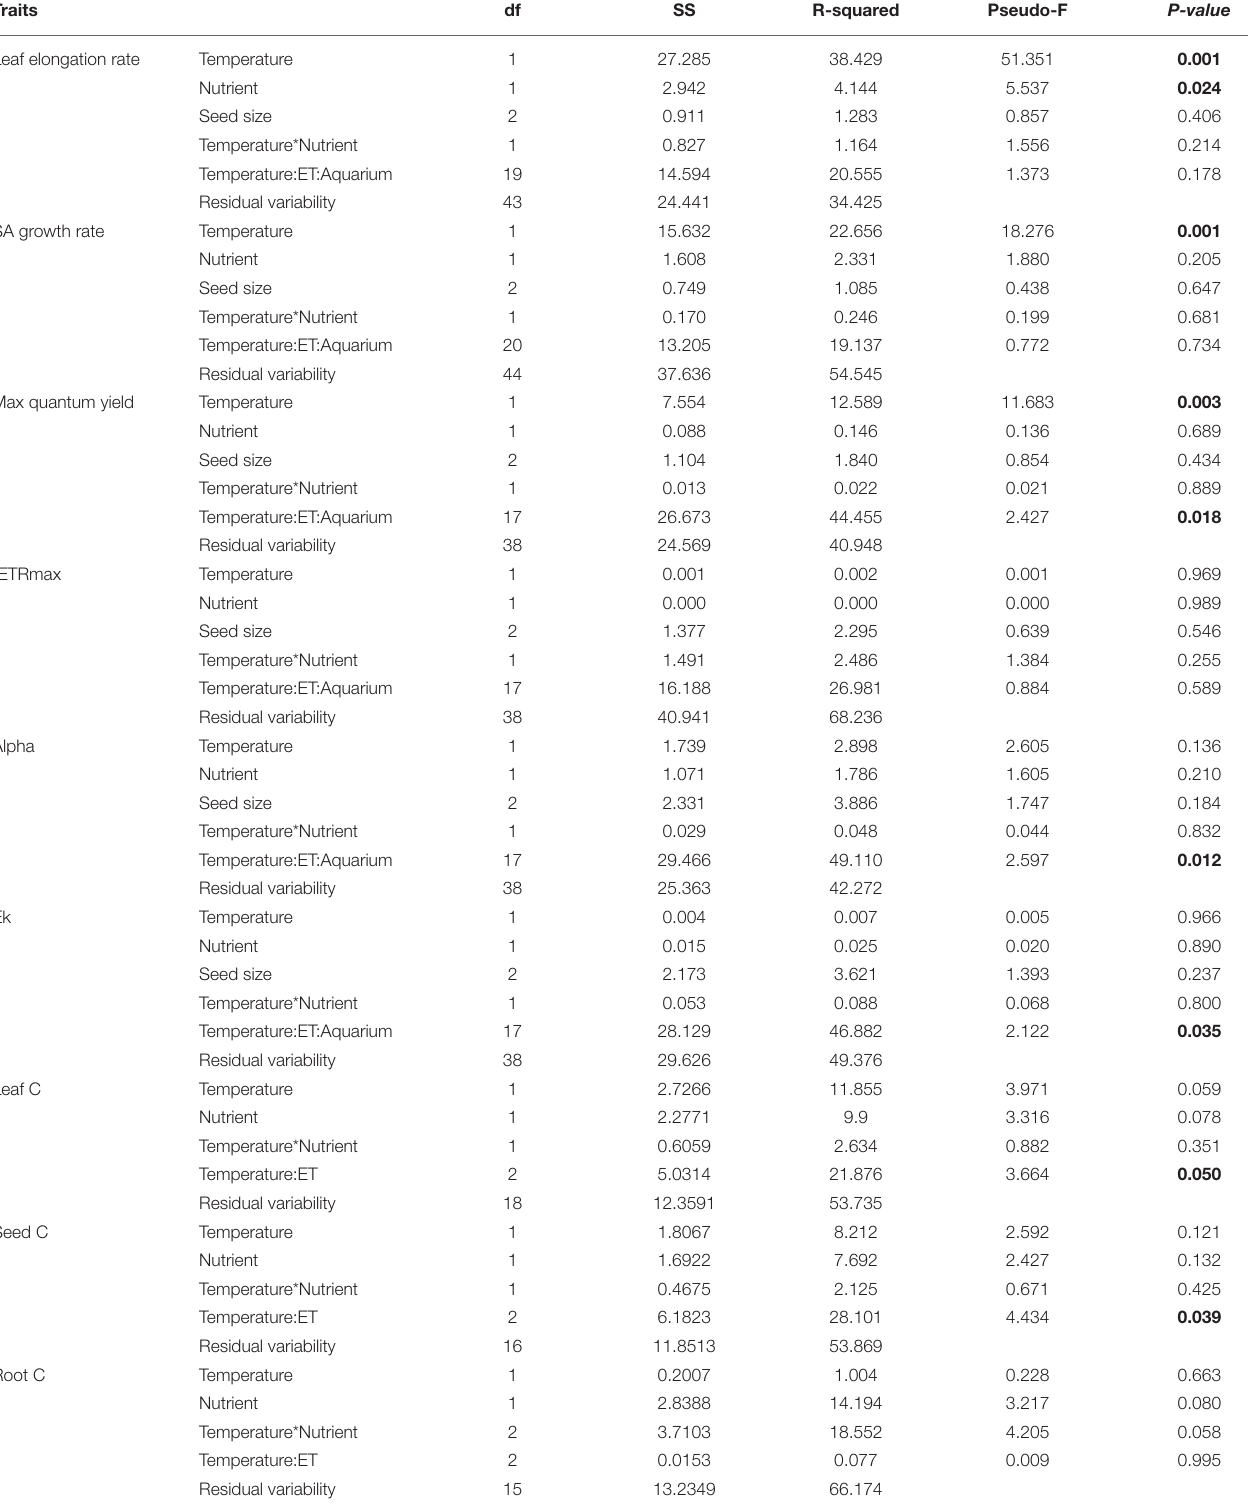
TABLE 5 | Results of the permutational analysis of variance (PERMANOVA) of the effects of temperature and nutrient treatments on the biochemical and physiological traits of Enhalus acoroides seedlings included in Table 3, with the exception of starch concentration in seeds. Traits df SS R-squared Pseudo-F